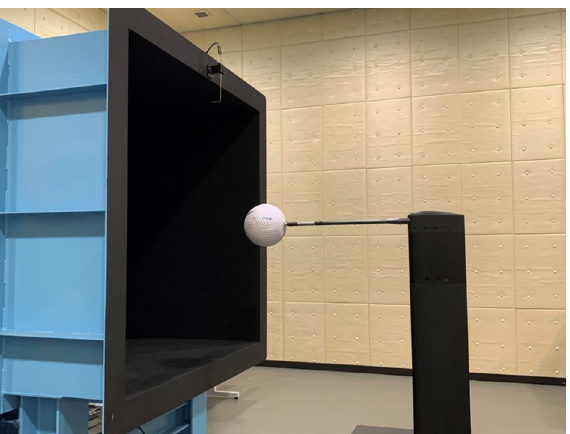
Figure 1. Setup of the circulation-type low-speed low-turbulence wind tunnel at the University of